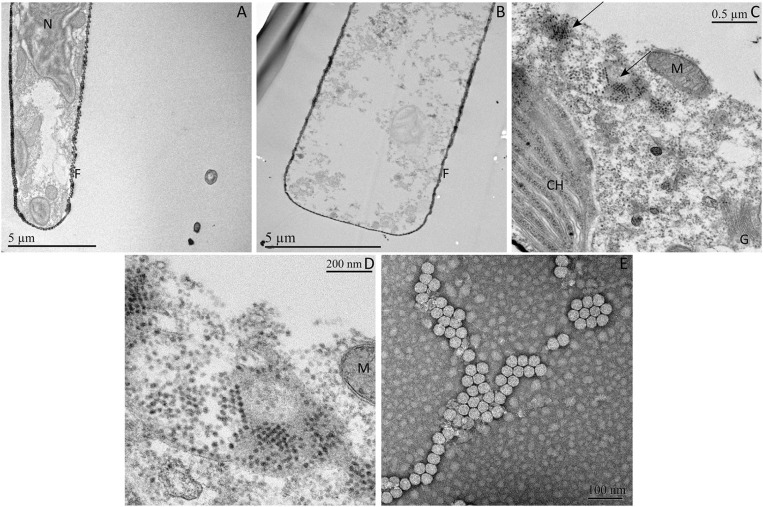
Ultrathin sections of Guinardia delicatula RCC3083 and negatively stained GdelRNAV-01 particles obtained by TEM. (A) Healthy control. (B–E)
G. delicatula infected by GdelRNAV-01 at 72 hpi. (C) Crystalline arrays and dispersed viral particles accumulated in the host cytoplasm. (D) Higher magnification of panel C of GdelRNAV-01 in the host cytoplasm. (E) Negatively stained GdelRNAV-01 particles. Arrows: Crystalline arrays. F, frustule; G, Golgi apparatus; M, mitochondrion; N, nucleus, CH, chloroplast.